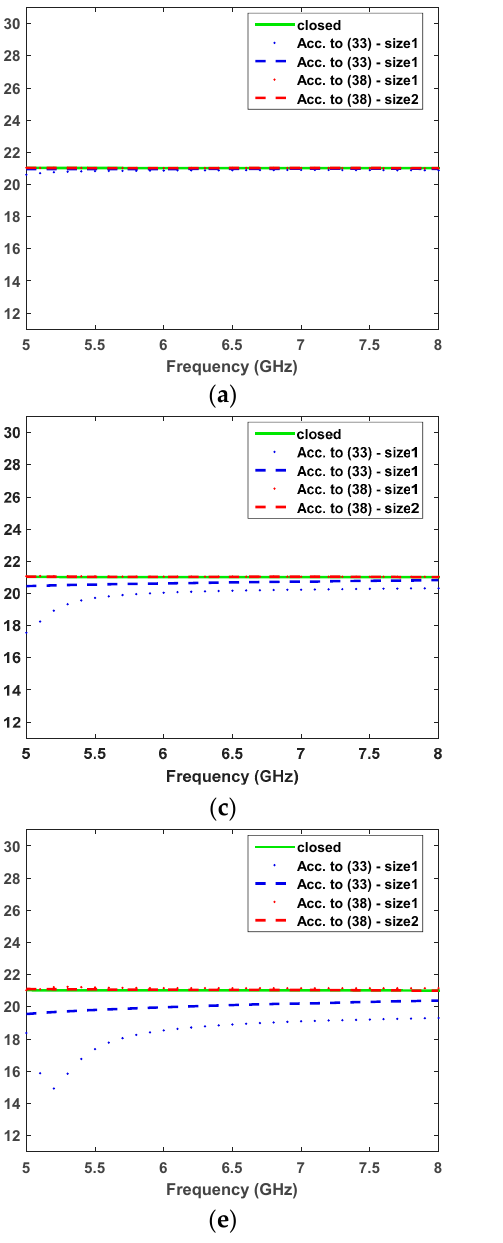
Figure 21. Estimated surface impedance (real and imaginary part) for three different thicknesses of the substrate: Z s was set to 20 + j0 in the simulations performed with Ansys Electronics v. 16. Closed: sample entirely contained in a closed waveguide. Size 1: Δ x = 2 mm, Δ y = 2 mm, Size 2: Δ x = 6 mm, Δ y = 4 mm. ( a , b ) d = 0.5 mm, ( c , d ) d = 1.5 mm, ( e , f ) d = 2.5 mm.